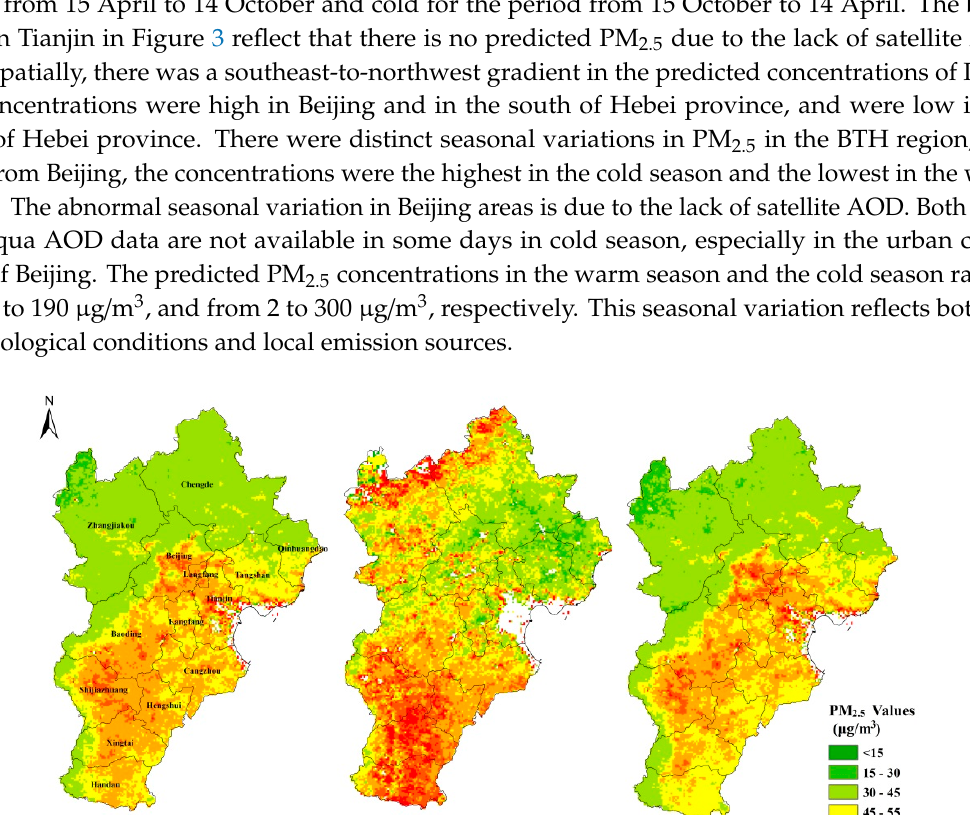
Figure 4. The population density across the BTH region in 2016.